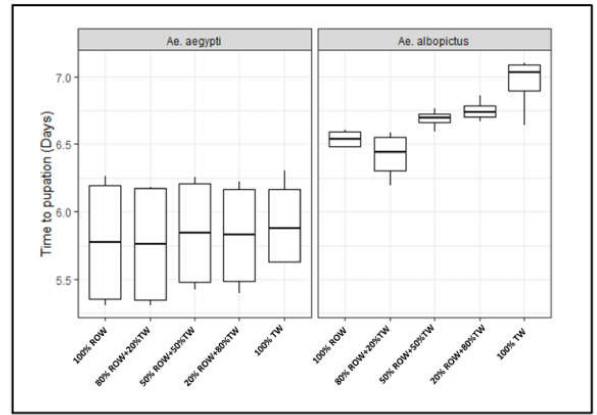
Figure 1. Time to pupation of Aedes aegypti and Aedes albopictus reared at different hardness/electrical conductivity levels of larval rearing water. As water hardness/electrical conductivity level increased, time to pupation gradually increased. Each box denotes the median as a line across the middle, the quartiles (25th and 75th percentiles), the minimum and maximum values at the ends of the vertical lines. Results are expressed as mean ± SE. ROW = reverse osmosis water, TW = tap